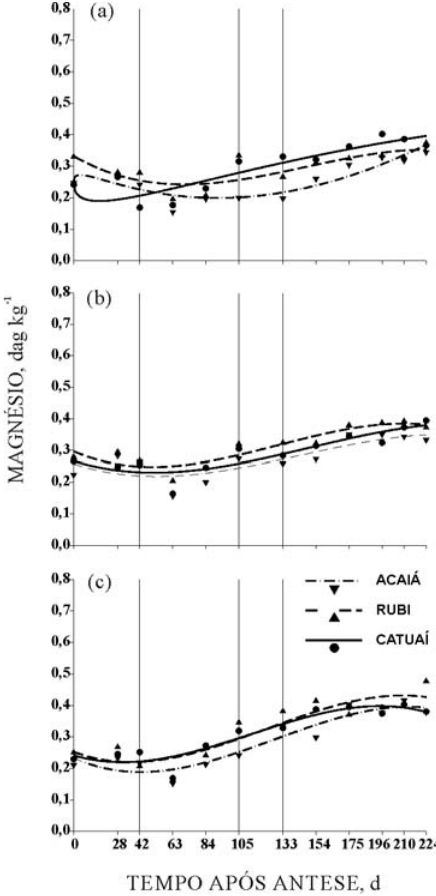
Figura 5. Concentração de magnésio em folhas de cafeeiro durante o período reprodutivo, nos níveis baixo (a), adequado (b) e alto (c) de adubação. As linhas verticais delimitam os estádios de desenvolvimento do fruto de chumbinho, expansão rápida, crescimento suspenso e